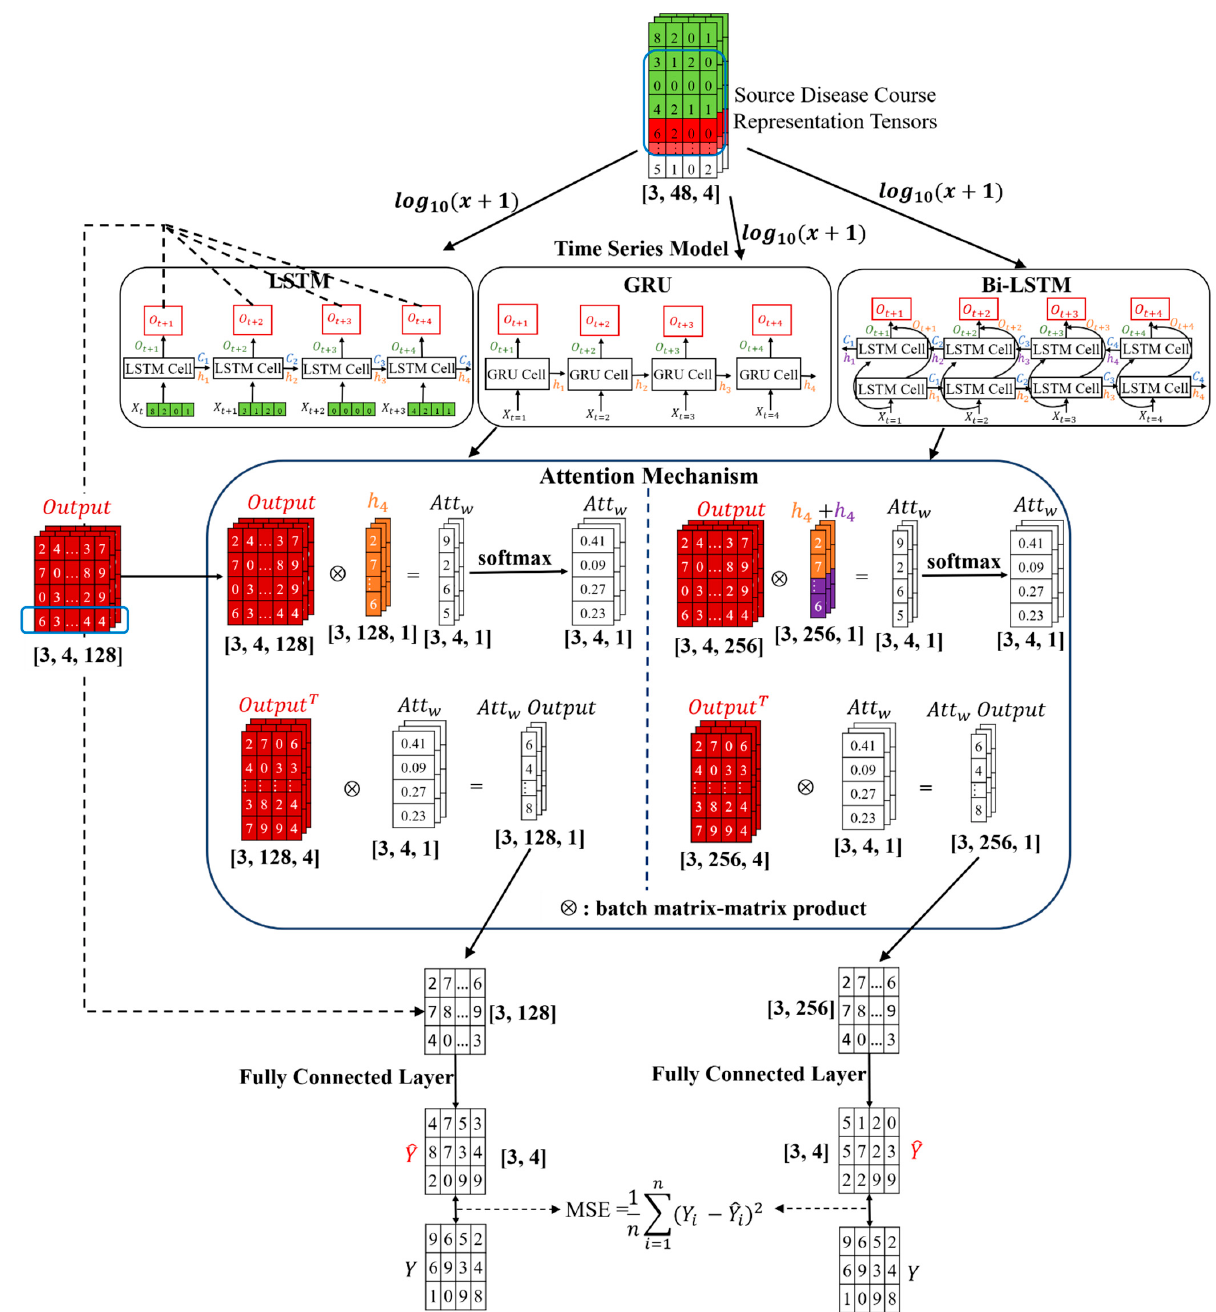
Figure 4. Prediction Model of Source Disease Course Development.